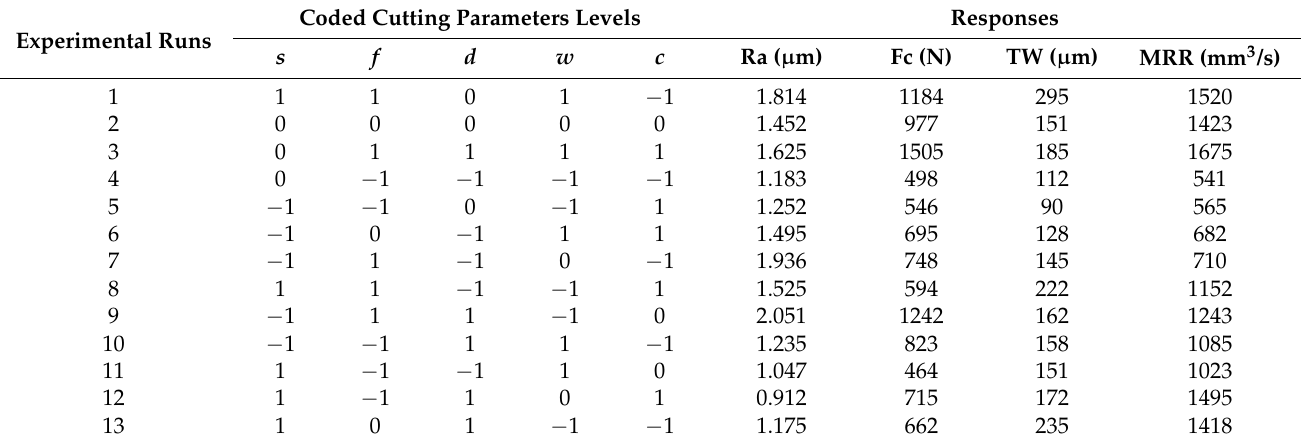
Figure 3. Methodology for single ‐ and multi ‐ response optimization.